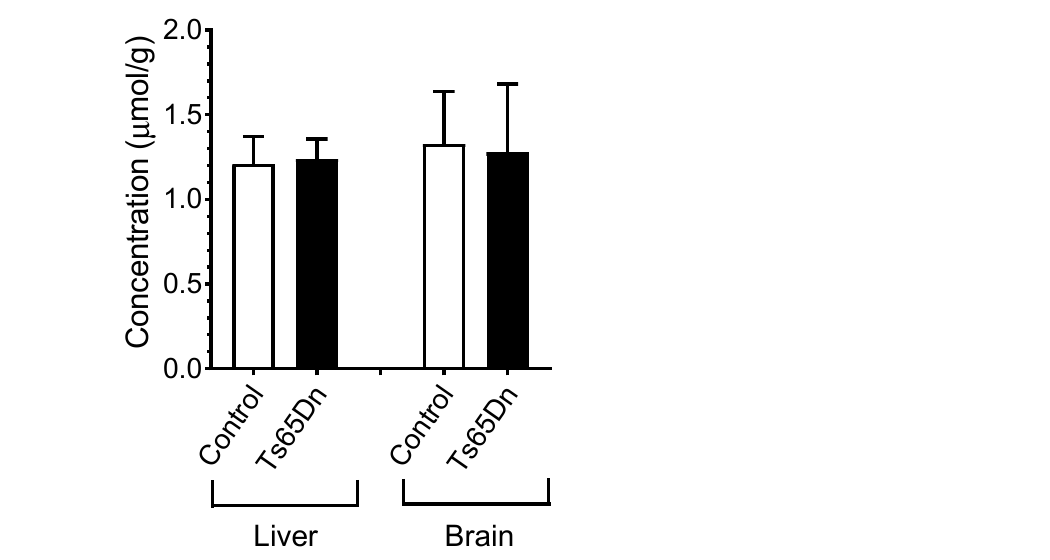
Figure 6. Levels of PST-001 found in the brain and in plasma after completion of the fear conditioning experiment.